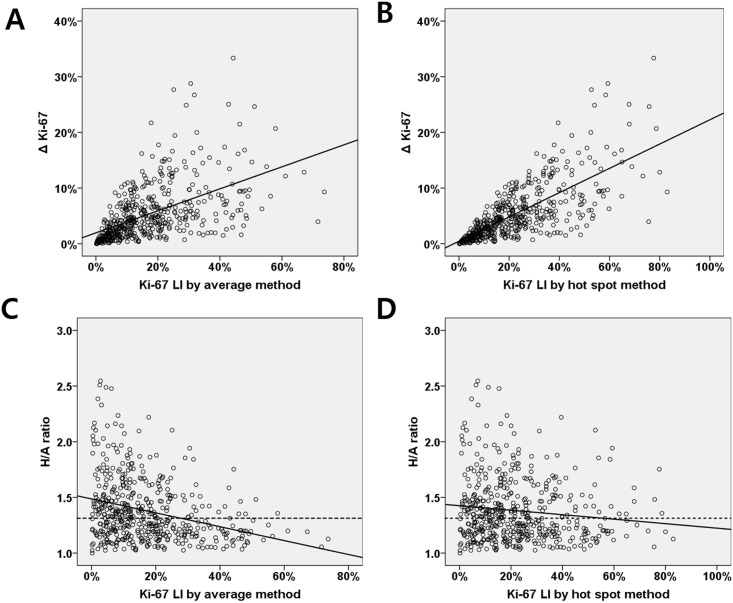
Correlation between Δ Ki-67, H/A ratio and Ki-67 labeling index measured by the two methods.(A, B) ΔKi-67 is moderately correlated with the Ki-67 labeling index (LI) based on the average method, and highly correlated with Ki-67 LI measured by the hot spot method (Pearson correlation coefficient, 0.535 and 0.731 respectively). (C, D) The H/A ratio is not correlated with Ki-67 LI measured by either method (Pearson correlation coefficients, -0.298 and -0.119, respectively).